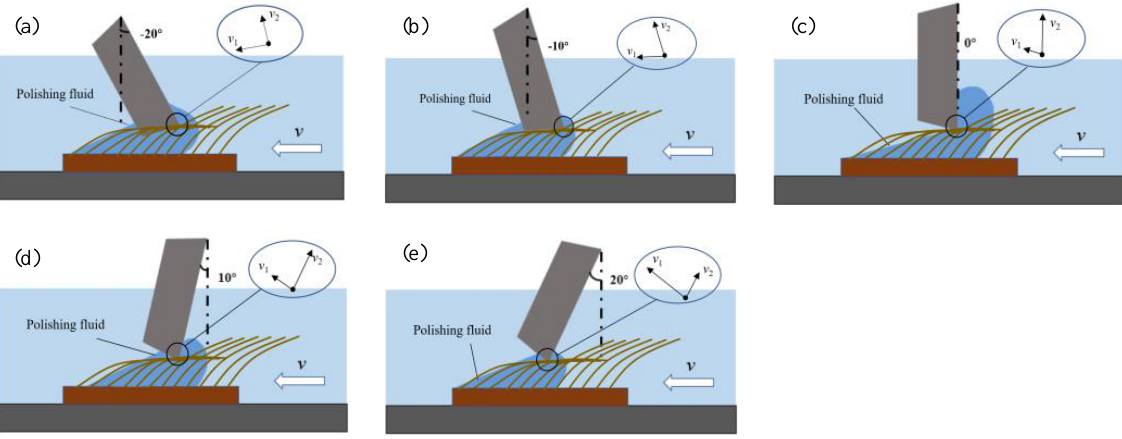
Figure 10. Schematic diagram of the change of K -factor: ( a ) initial, K = s α /s γ = 0.14, ( b ) − 20° , K = s α /s γ = 0.56, ( c ) 20°, K = s α /s γ = 0.26.